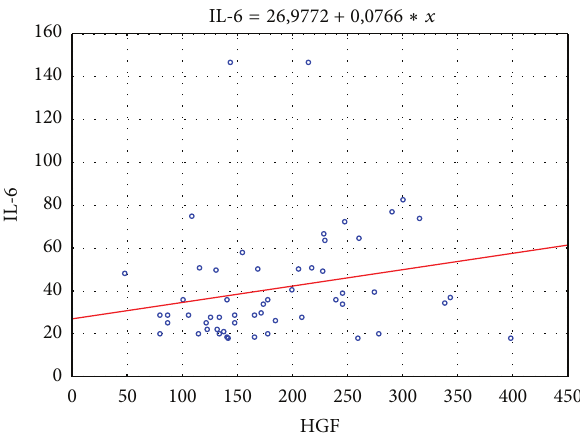
Figure 4: Correlation between HGF and IL-6 in the study popula- tion ( 𝑟 = 0.32 ; 𝑝 = 0.016 ).